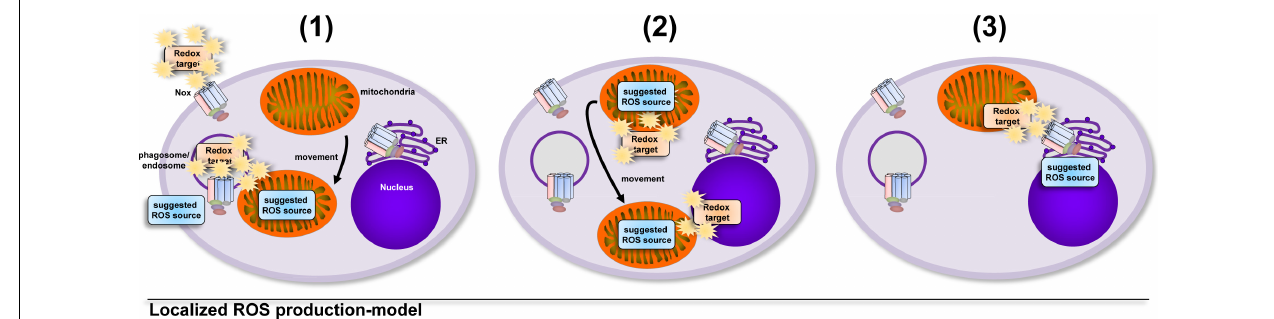
FIGURE 2 | Growing evidence supports the hypothesis that cellular compartments show big differences and tight regulation of their redox status. The induction of ROS production is controlled by the cell in terms of location, source, duration and amount. The localized and timely controlled ROS production in the direct vicinity of the redox-sensitive target reduces the induced damage to cellular components and results in beneficial consequences for the cell, a condition termed as oxidative eustress (Sies, 2021). Examples of localized ROS production are (1) the production of antimicrobial ROS by Nox2 (Craig and Slauch, 2009; Gluschko et al., 2018) or mitochondria, which are recruited to pathogen-containing phagosomes (West et al., 2011a; Geng et al., 2015), (2) the recruitment of the redox-regulated target to ROS-producing mitochondria for NLRP3 inflammasome activation (Zhou et al., 2011) or the relocation of mitochondria to the nucleus for ROS-mediated nuclear signaling (Al-Mehdi et al., 2012) and (3) ROS production by ER-localized Nox4 during formation of mitochondria-associated membranes for regulation of calcium signaling (Beretta et al.,